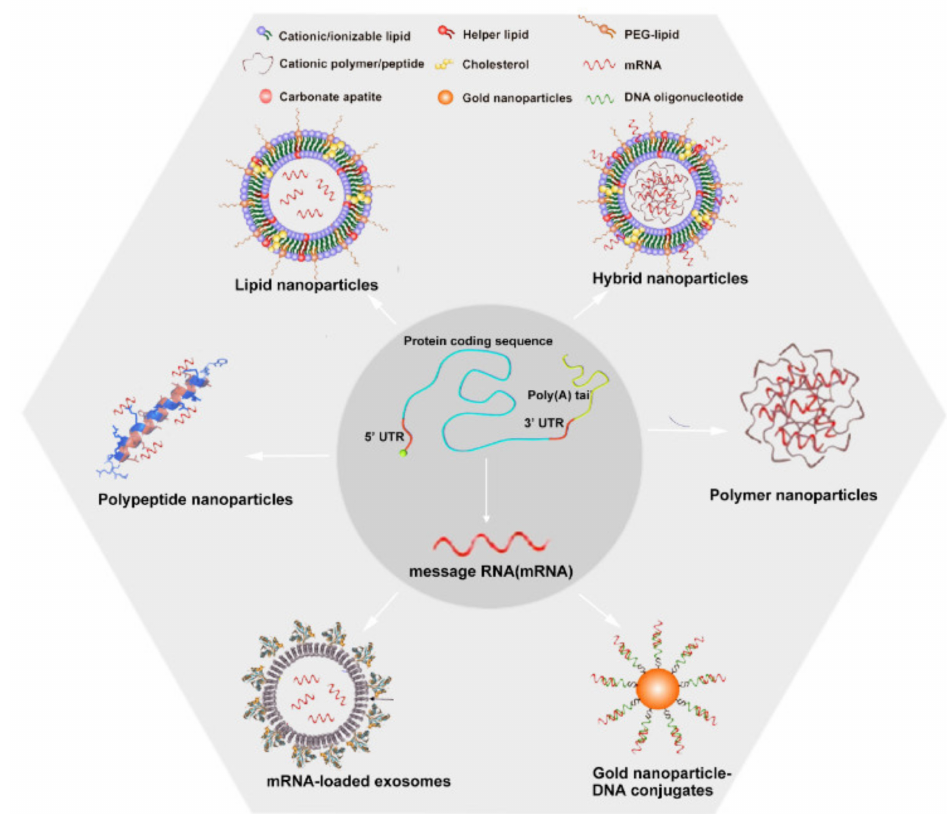
Figure 5. Nanosystem approaches for mRNA delivery. There are six major kinds of nanoparticles (NPs) used as delivery systems for mRNA cancer vaccines: including lipid nanoparticles (LNPs), hybrid NPs, polymer NPs, gold NP–DNA oligonucleotide conjugates (AuNP–DNA conjugates), mRNA-loaded exosomes, and polypeptide NPs. In these systems, the mRNA has the same structure as endogenous eukaryotic mRNA with the five basic elements described